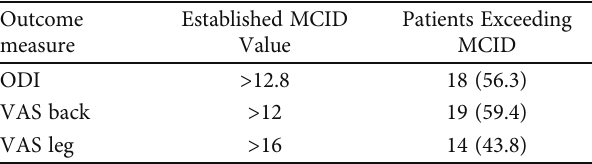
Values represent the number of patients (%). MCID: minimum clinically important di ff erence; ODI: Oswestry Disability Index; VAS: Visual Analog Scale. Table 6: Postprocedure surgery details.